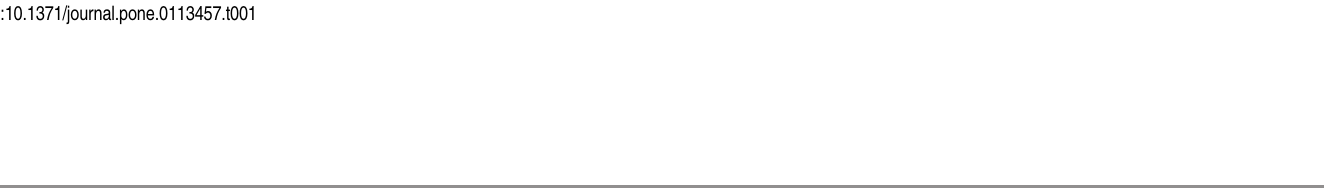
denotes the data